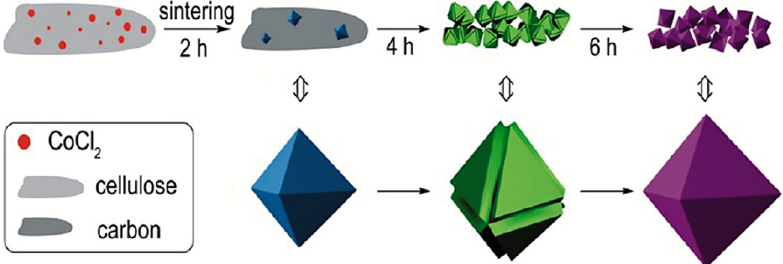
Figure 11. The schematic illustration describing a time-dependent growth of Co 3 O 4 . Reprinted with permission from [ 250 ] . Copyright 2014 American Chemical Society.